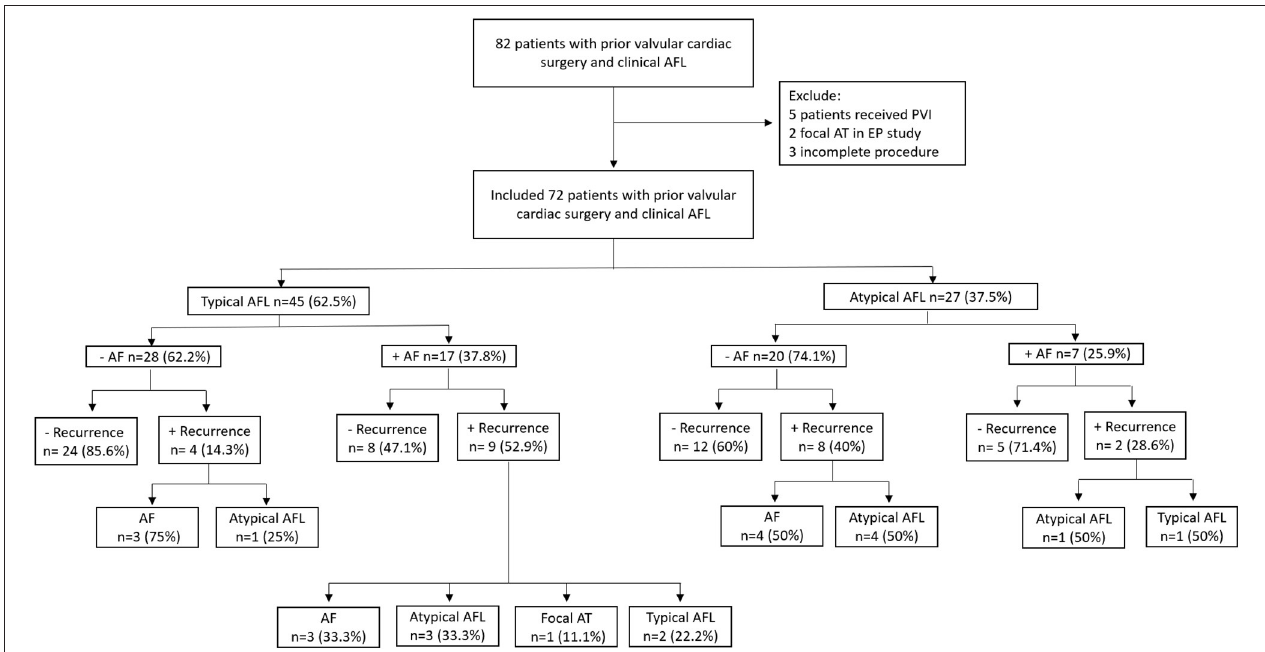
FIGURE 1 | Flowsheet of the inclusion, classification of subgroups, recurrence number, and patterns in our study cohort. AFL, atrial flutter; AF, atrial fibrillation; AT, atrial tachycardia; PVI, pulmonary vein isolation; EP, electrophysiology.